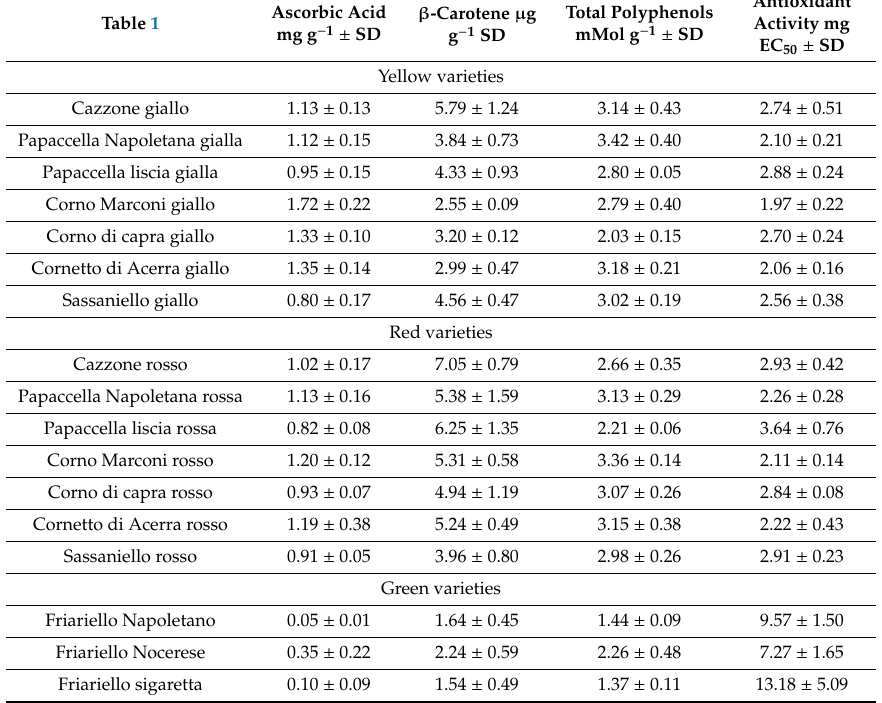
Table 1. Content of ascorbic acid, β -carotene, total polyphenols and antioxidant activity exhibited by the yellow, red and green traditional varieties of sweet pepper of the Campania region. Data represent the average ( ± SD) of three independent experiments. For details, see the Section Materials and